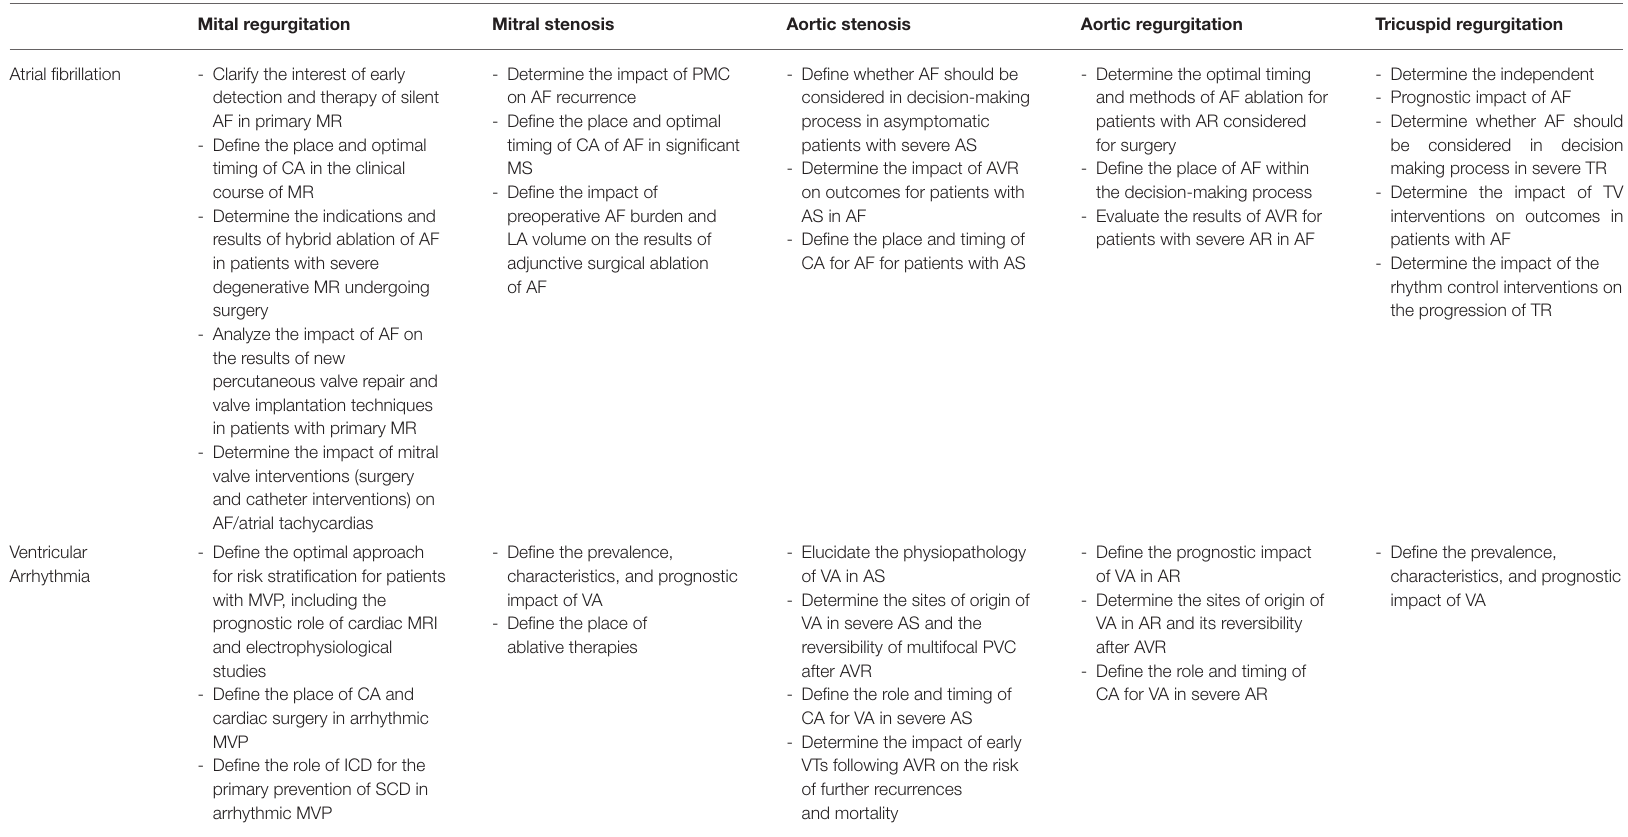
TABLE 2 | Gaps in evidence in the management of atrial fibrillation and ventricular arrhythmias coexisting with particular subtypes of valvular heart disease. Mital